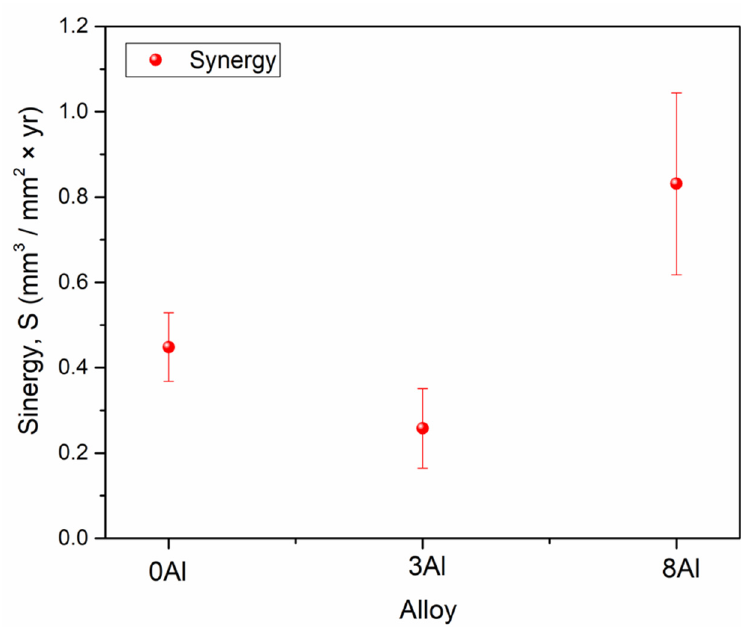
Figure 11. Synergy behavior of the alloys.